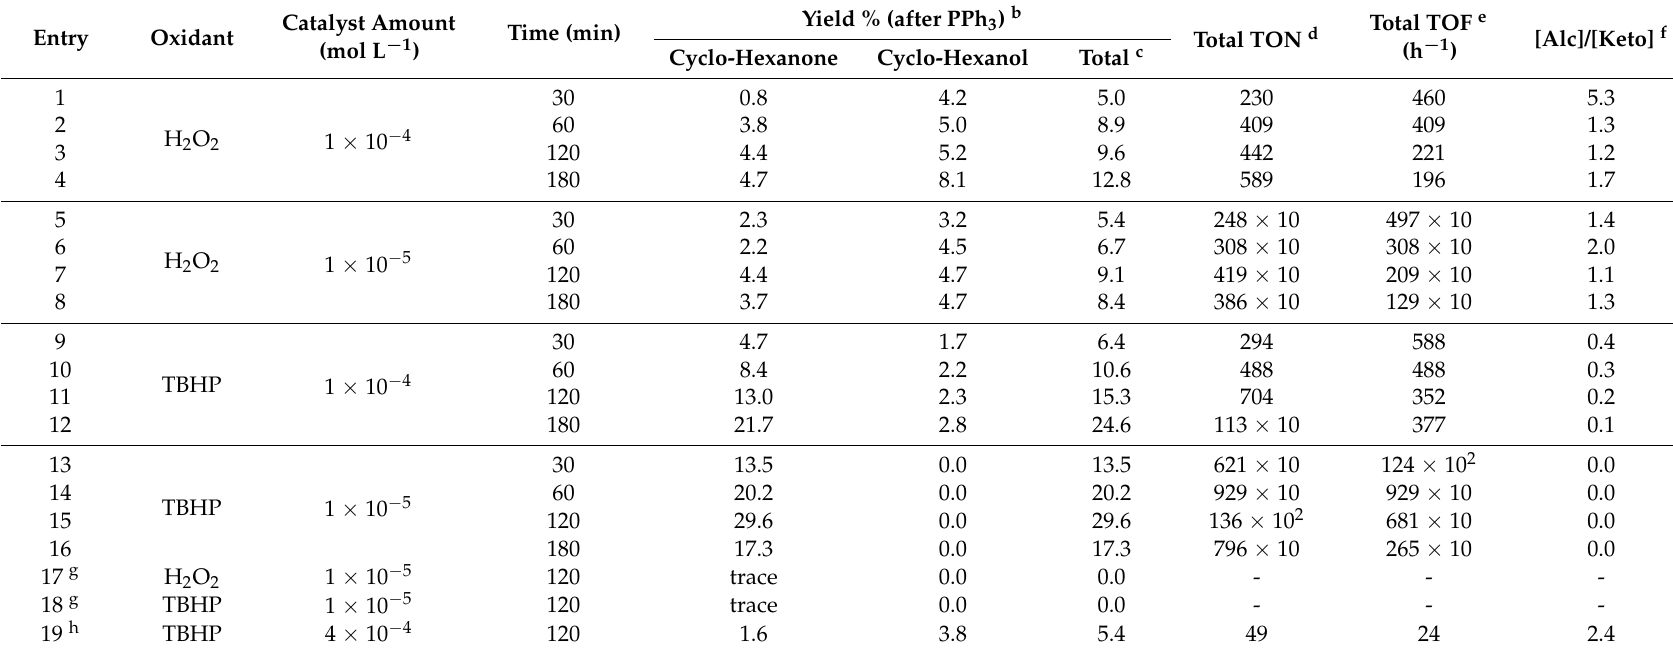
Table 1. Oxidation of cyclohexane to cyclohexanol and cyclohexanone catalysed by 1 a